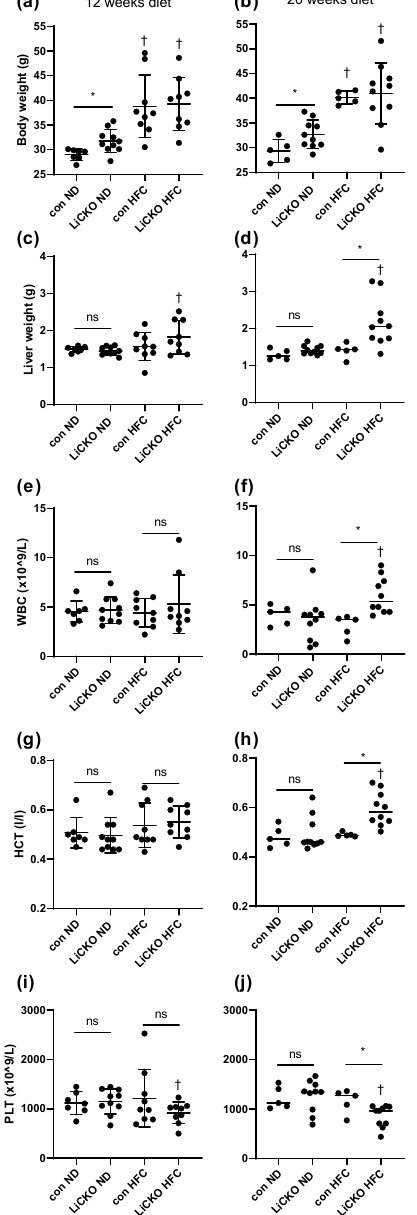
Figure 2. Body weight, liver weight, WBC, HCT, and PLT. ( a , b ) At 12 and 20 weeks of diet, body weight was higher in ND-fed LiCKO mice than controls on ND. Body weight of all groups on HFC diet were significantly increased compared with mice on ND, without differences between genotypes; ( c ) Liver weight of LiCKO mice on HFC diet was significantly increased over LiCKO on ND; ( d ) Liver weight of LiCKO mice on HFC diet was significantly increased over controls on HFC diet and over LiCKO on ND; ( e ) At 12 weeks of diet, no differences were observed in WBC; ( f ) At 20 weeks of diet, WBC in LiCKO mice on HFC diet was significantly increased over controls on HFC diet and over LiCKO on ND; ( g ) At 12 weeks of diet, no differences were observed in HCT; ( h ) At 20 weeks of diet, HCT in LiCKO mice on HFC diet was significantly increased over controls on HFC diet; ( i ) At 12 weeks of diet, no differences were observed in PLT; ( j ) At 20 weeks of diet, PLT in LiCKO mice on HFC diet was significantly decreased over controls on HFC diet and over LiCKO on ND; WBC; white blood cell count, HCT; hematocrit; PLT; platelet count; * p < 0.05 difference between con and LiCKO on same diet; † p < 0.05 difference between ND and HFC for con or LiCKO; ns =